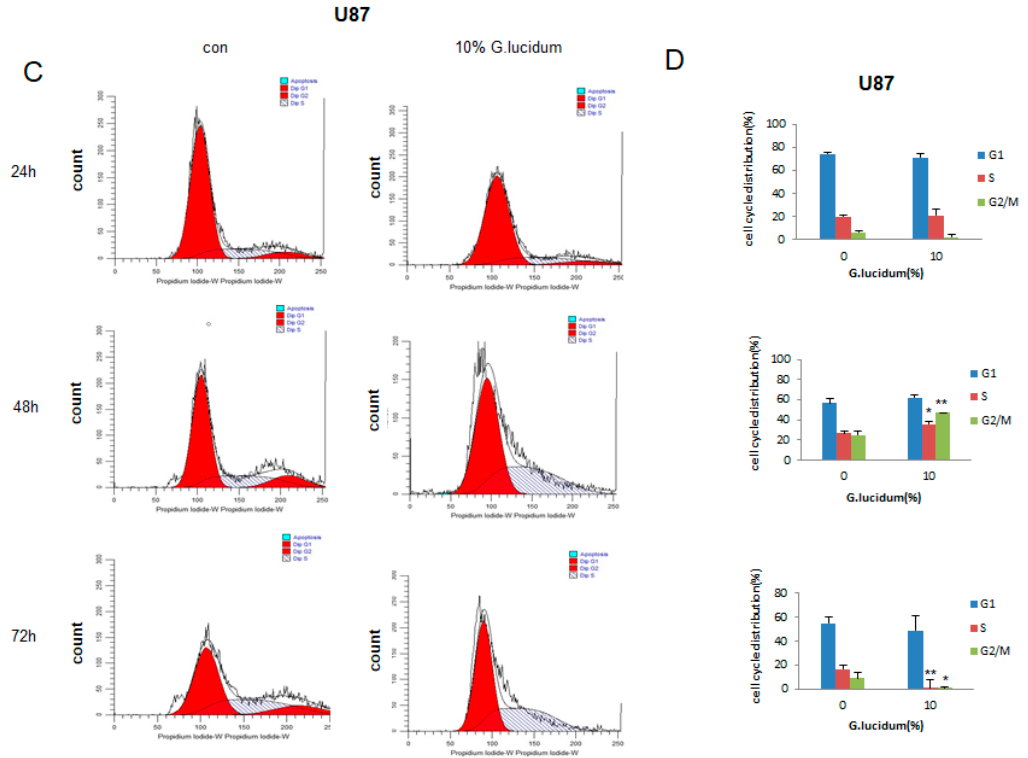
Figure 3. G. lucidum extract induces S phase cell cycle arrest in glioblastoma cells. ( A , C ) Cultures of ( A ) GBM 8901 and ( C ) U87 cells were treated with 10% G. lucidum extract for 24, 48, and 72 h, and the cell cycle distribution was assessed after PI staining by flow cytometry. ( B , D ) Cell cycle distribution of ( B ) GBM 8901 and ( D ) U87 cells. * p < 0.05; ** p < 0.01.